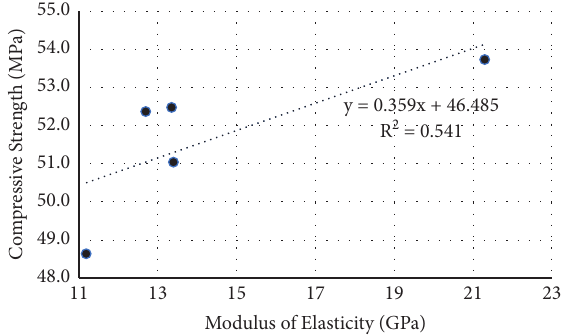
Figure 17: Fitted line plots of regression analysis for the rela- tionship between compressive strength and modulus of elasticity on 28-day curing.